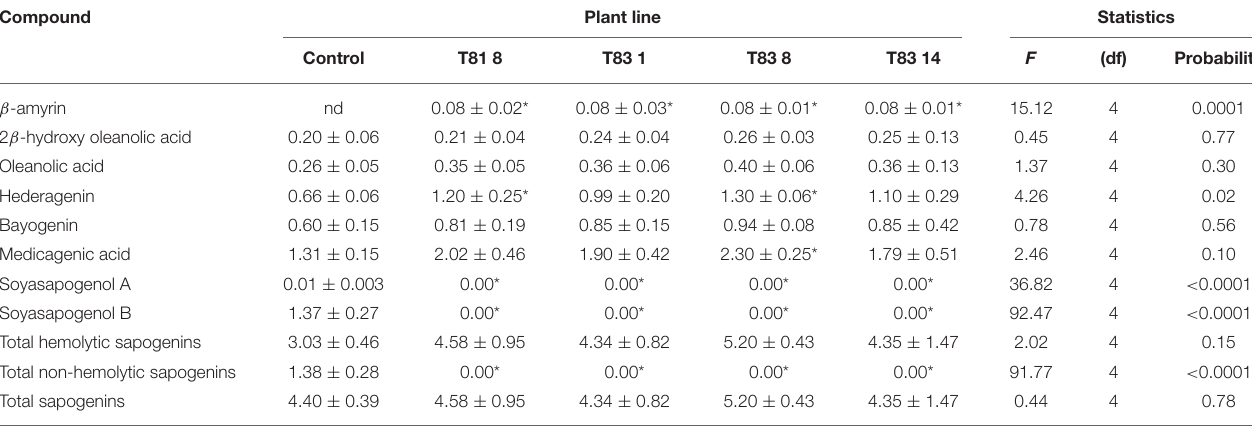
TABLE 2 | Sapogenin content in roots of control and CYP93E2 mutant barrel medic plant lines under greenhouse experimental conditions.